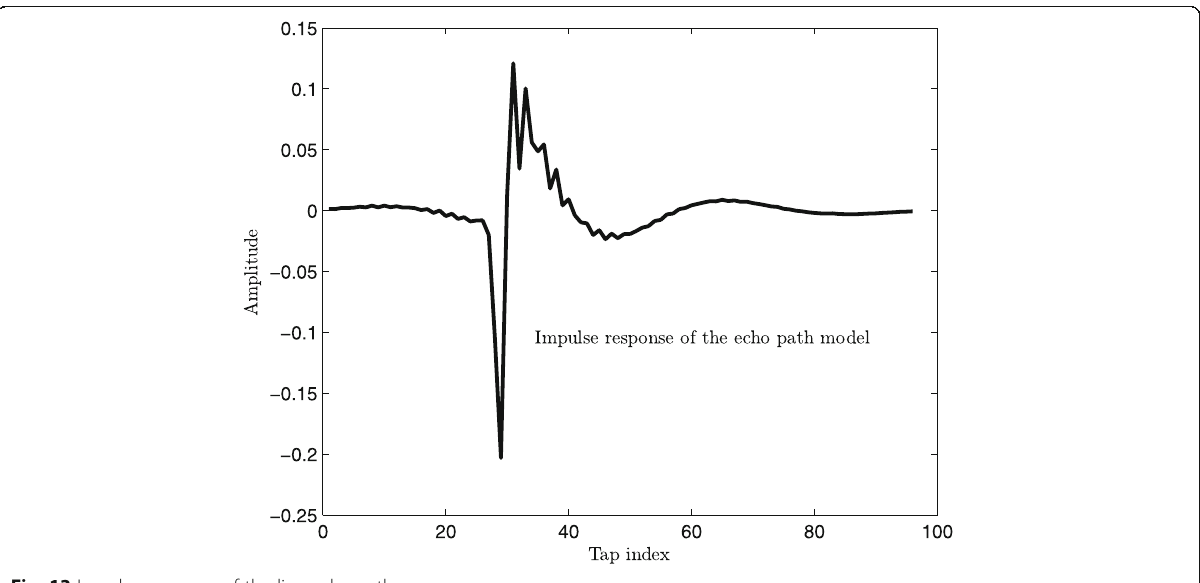
Fig. 13 Impulse response of the line echo path